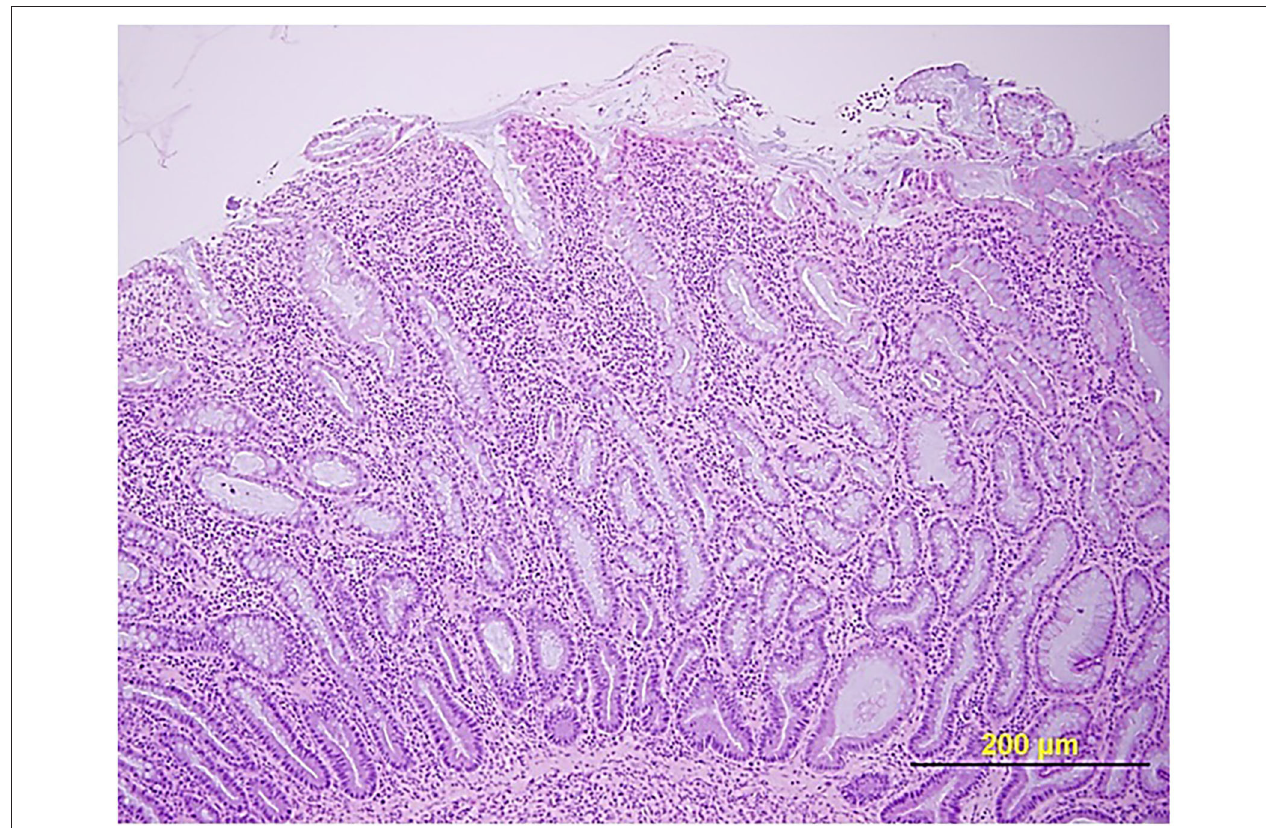
FIGURE 4 | Histopathologic evidence of intestinal barrier disruption. Duodenal biopsy showing focally extensive villus erosions covered by neutrophils and cell debris in a dog with CIE. Hematoxylin and eosin (HE) stain. From: (110), with